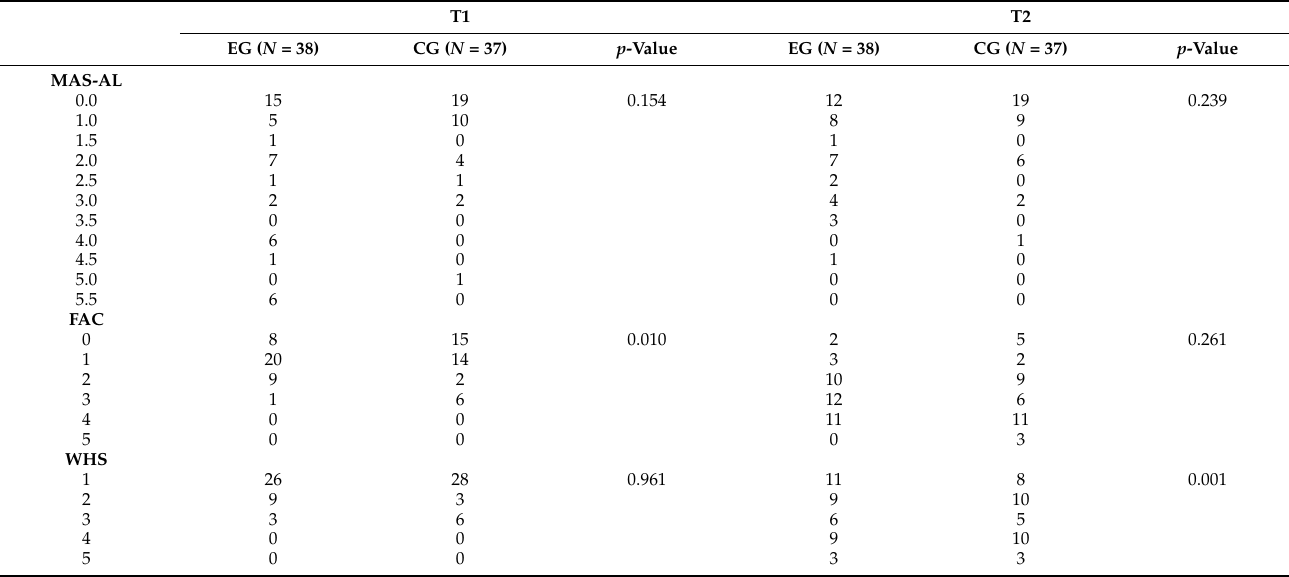
Table 3. Results of the chi-squared test between the Modified Ashworth Scale of the Affected lower Limb (MAS-AL), Functional Ambulation Classification (FAC), and Walking Handicap Scale (WHS) classes and the Experimental Group (EG) and Control Group (CG)